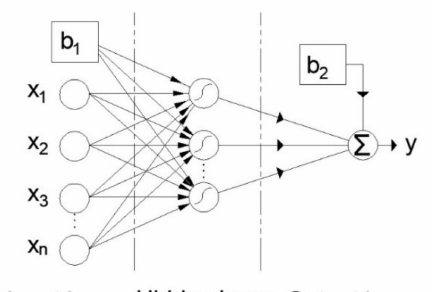
Figure 9. Multilayer perceptron artificial neural network